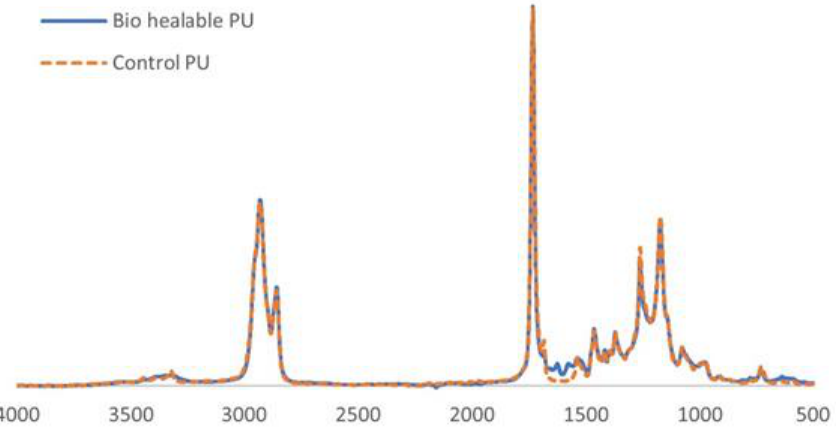
Figure 1. FT-IR spectra of bio-based healable and control PU.